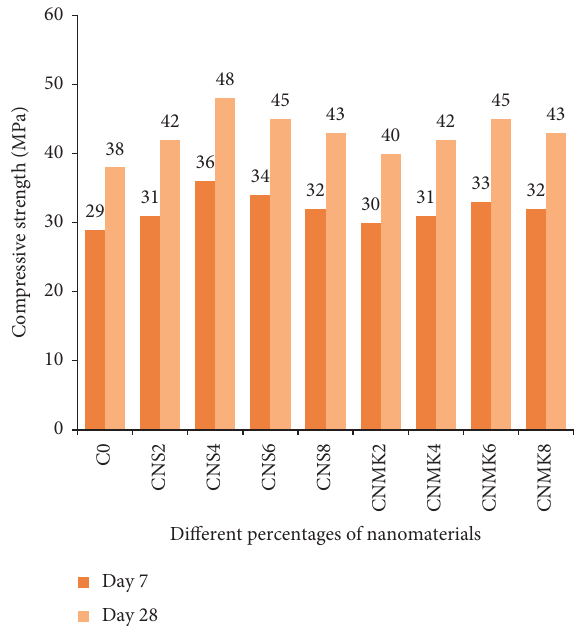
Figure 4: Effect of NS and NMK on compressive